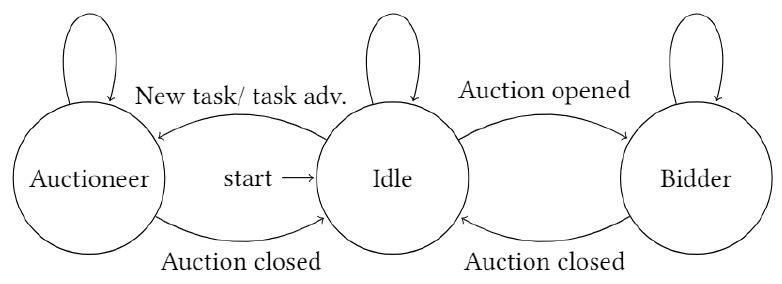
Figure 3. A robot state diagram in during auction